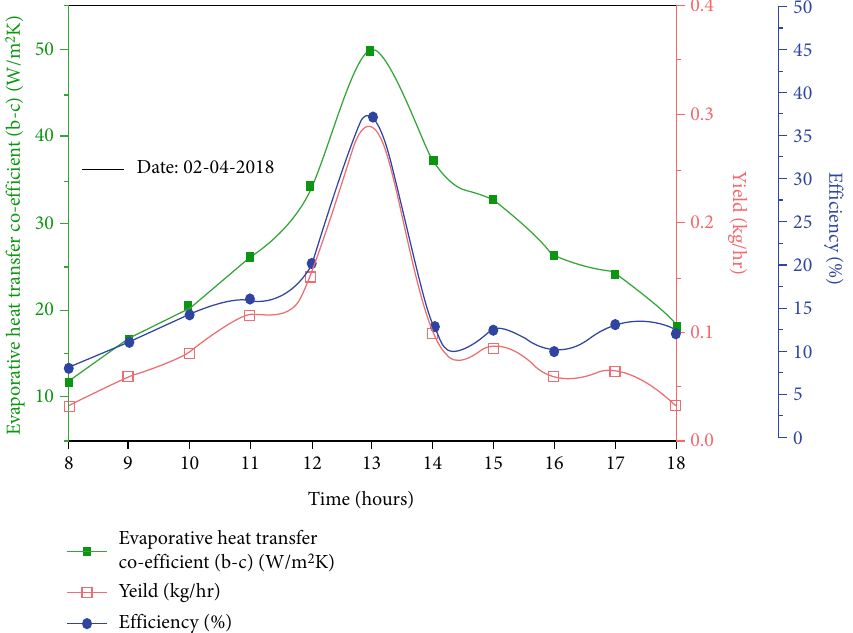
Figure 29: E ffi ciency, productivity, and evaporative heat transfer coe ffi cient of the air-packed pyramid shape solar still